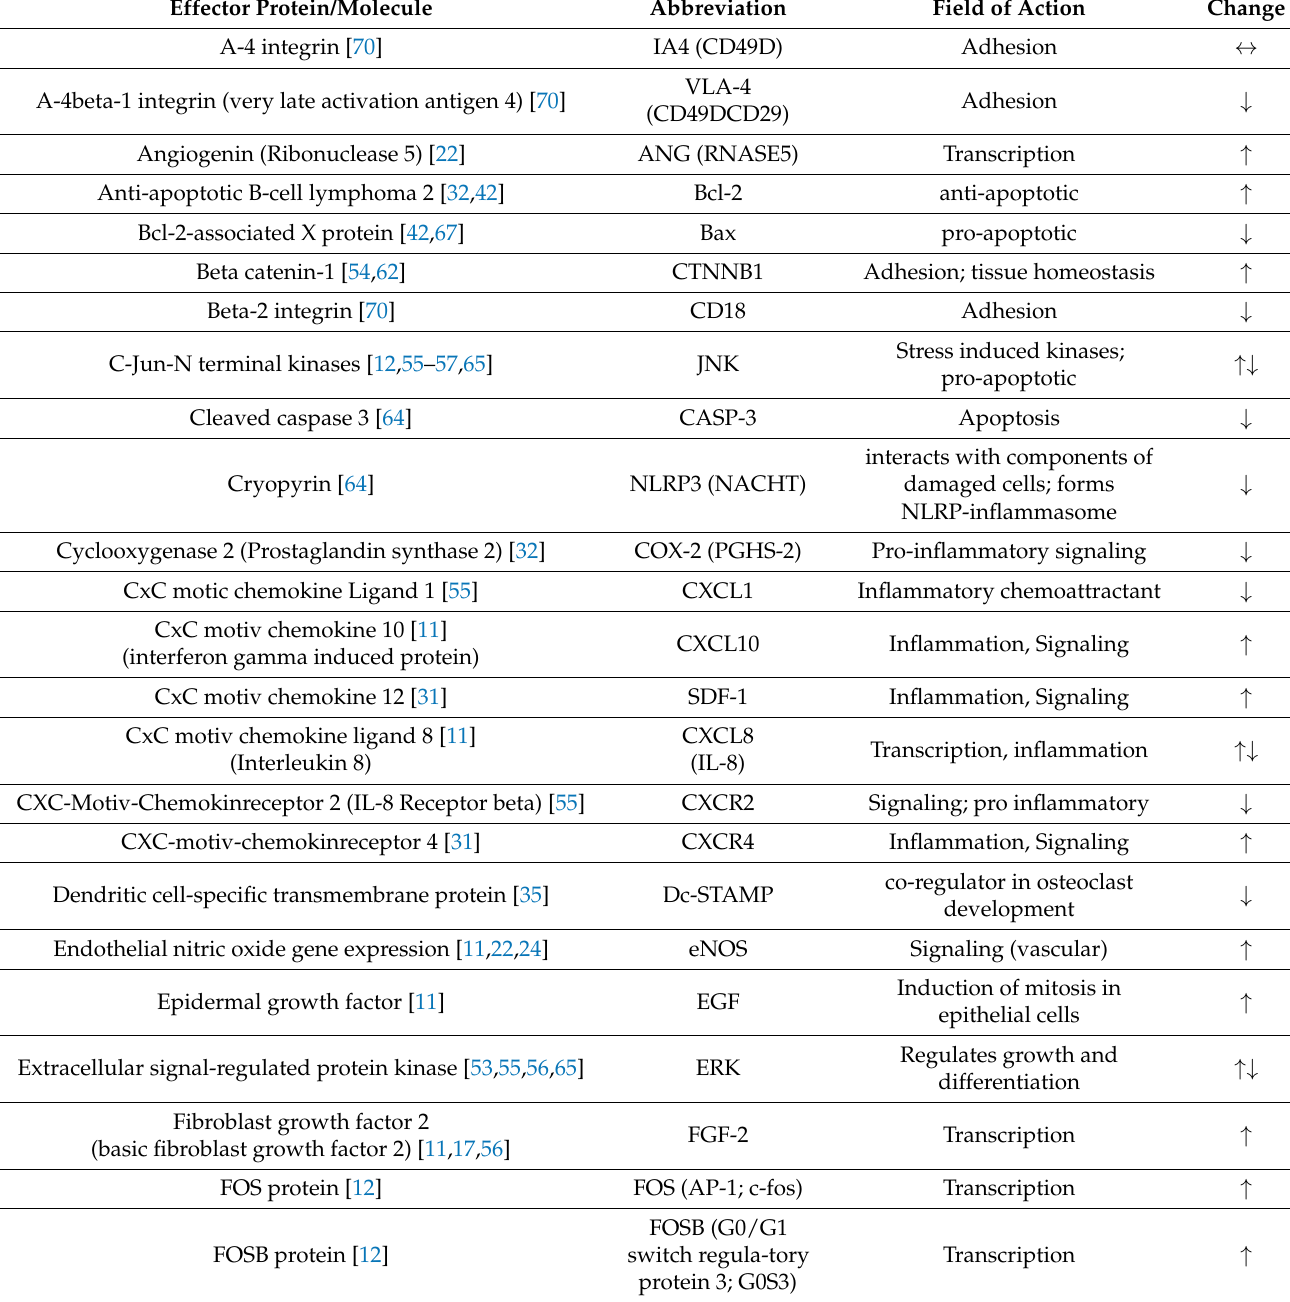
Table 1. Tissue regeneration. Mechanisms involved in effectiveness of HBO; The arrows indicate the effect of HBO on the level of the effector molecule initially found during respective study (in alphabetical